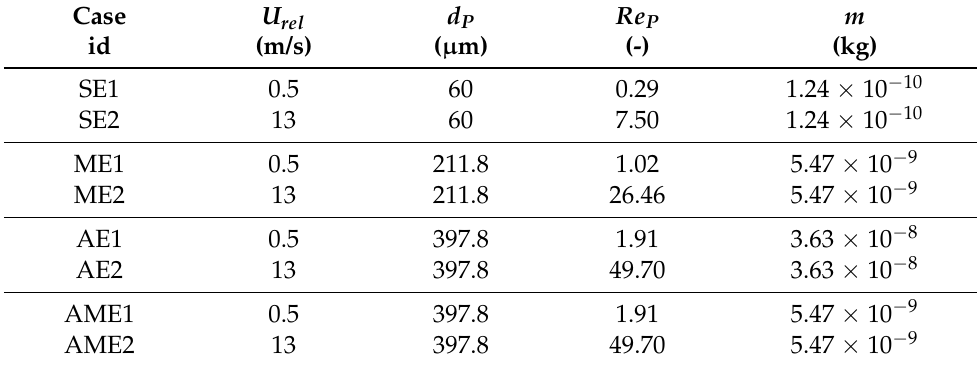
Table 4. Summary of single sphere reference cases.